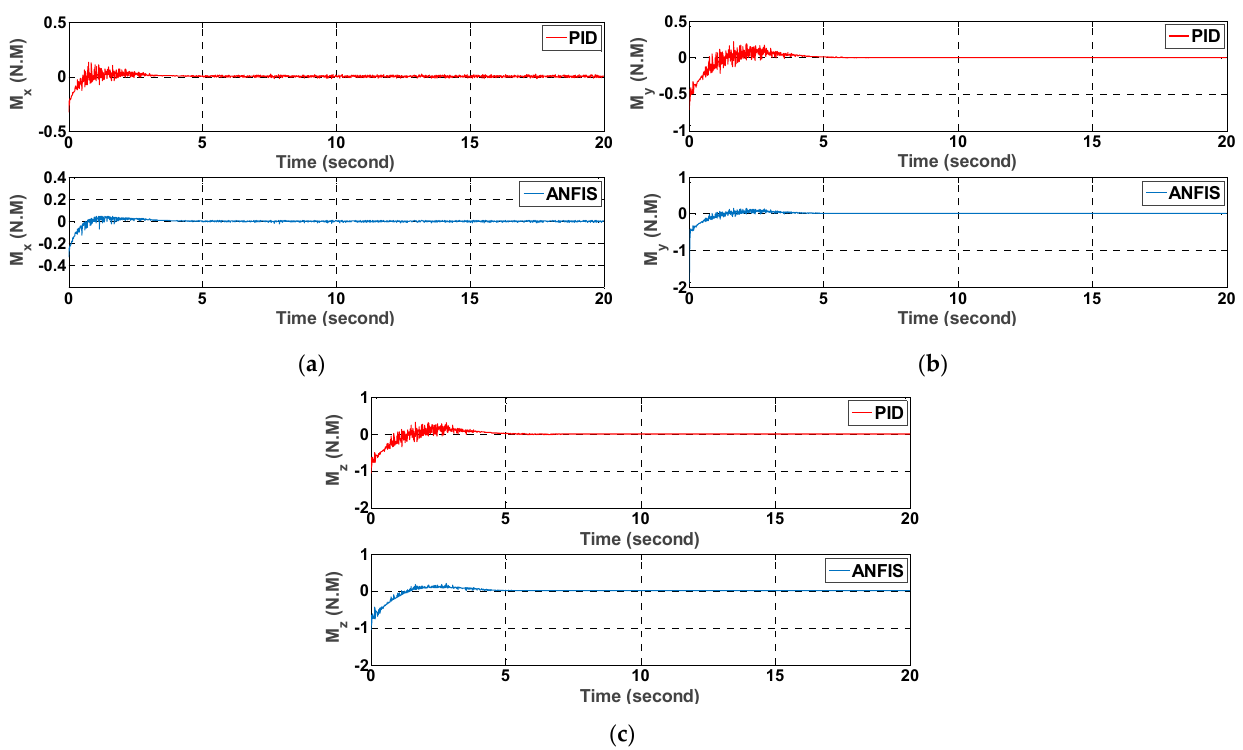
Figure 7. Comparison of control moments in ( a ) X, ( b ) Y, and ( c ) Z directions using ANFIS and PID in the presence of noise.